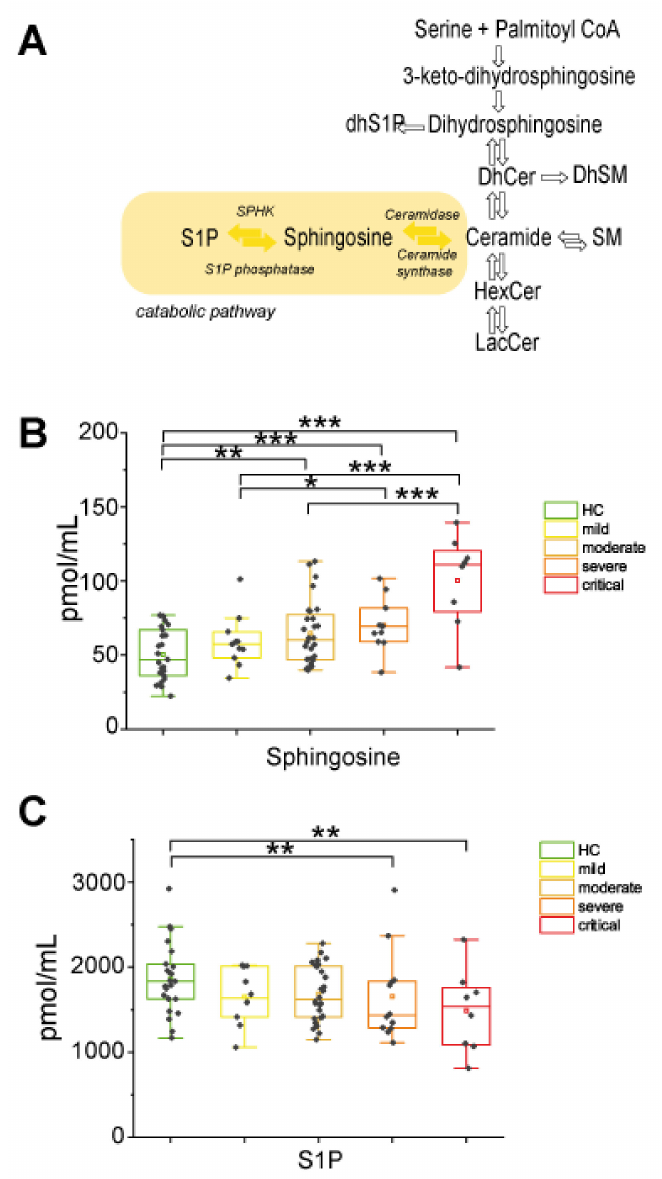
Figure 4. Sphingosine and sphingosine-1-phosphate changes in COVID-19. ( A ) Close up of the catabolic pathway, highlighted in yellow. ( B ) Box plots of sphingosine serum levels. ( C ) Box-plot of S1P serum levels. Each measurement was performed in triplicate. Data were analyzed using Kruskal-Wallis ANOVA, followed by Dunn’s post hoc test for multiple comparisons. * p -value < 0.05, ** p -value < 0.01, *** p -value <